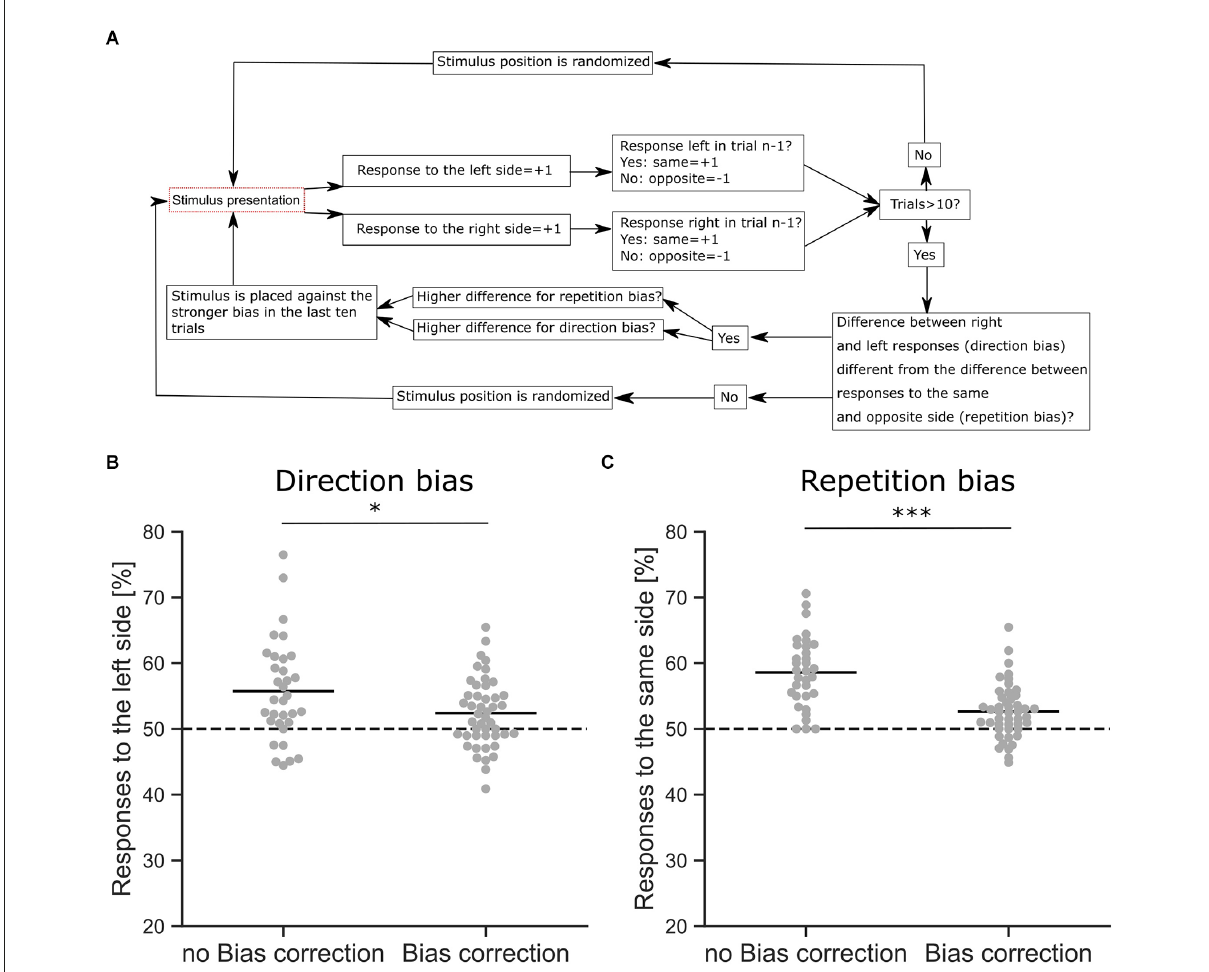
FIGURE3 Response bias correction. (A) Schematic overview of the bias correction algorithm. (B) Comparison of a direction bias with ( n = 46 sessions from six mice) and without bias correction ( n = 33 sessions from six mice), shown as the proportion of responses to the left side. The difference between the proportions is significant (z-Test, p = 0.042). (C) Comparison of a repetition bias with ( n = 46 sessions from six mice) and without bias correction ( n = 33 sessions from six mice), shown as the proportion of responses to the same side as in the trial before. The difference between the proportions is significant (z-Test, p < 0.001). ∗ p < 0.05, ∗∗∗ p <